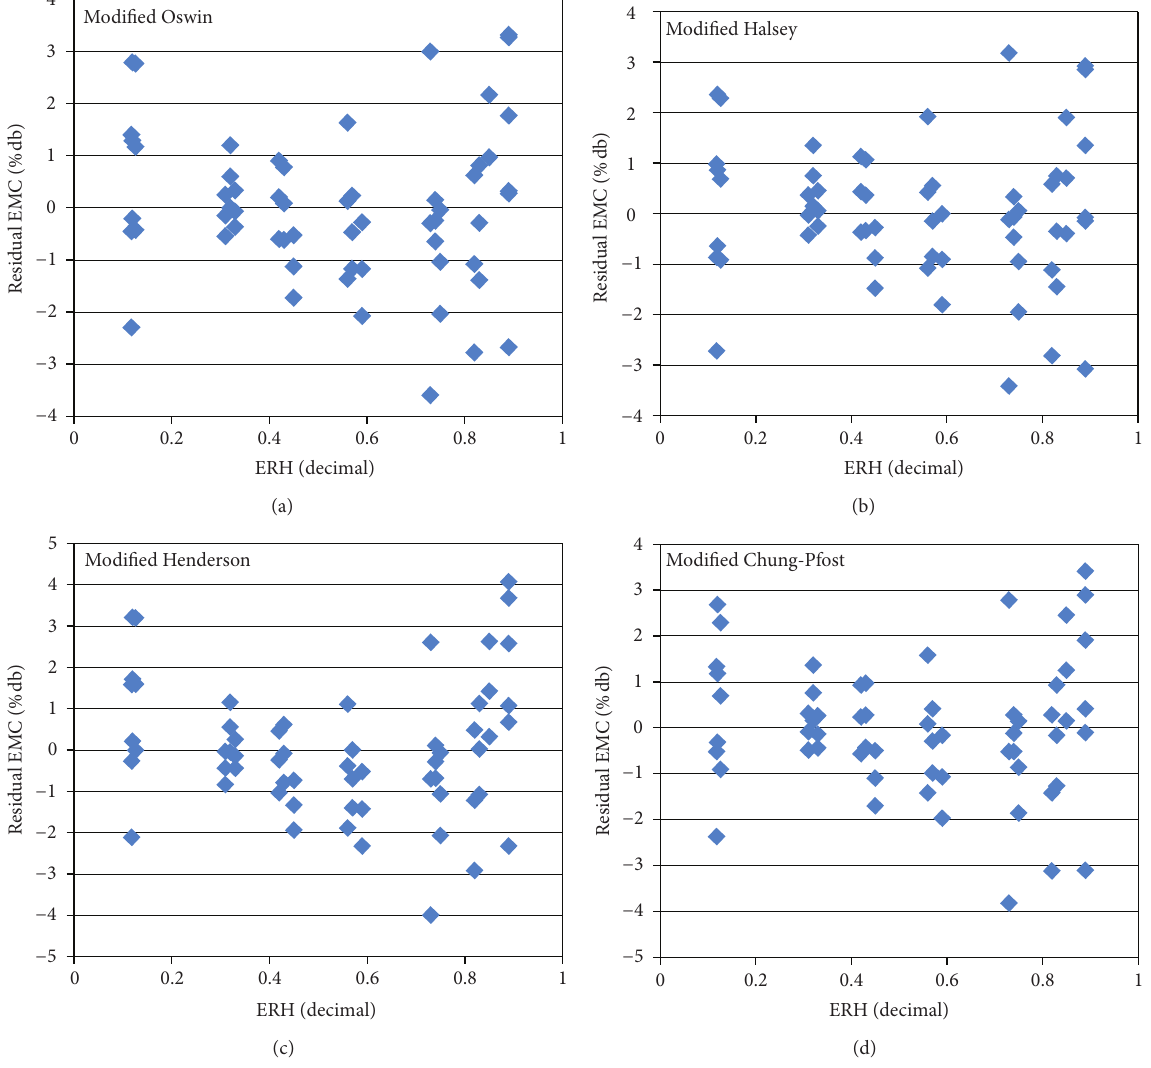
Figure 2: Residual plots of the fitted isotherm equations for the moisture isotherm data of corn stover at temperatures 20 to 40 ∘ C.